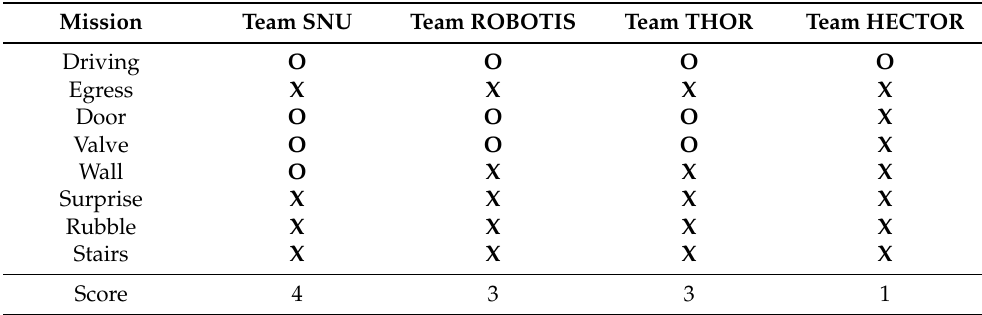
Table 1. Scores of THORMANG-based teams in DRC Finals. Team SNU successfully performed 4 missions ( O ), but failed 4 missions ( X ), including the egress task.